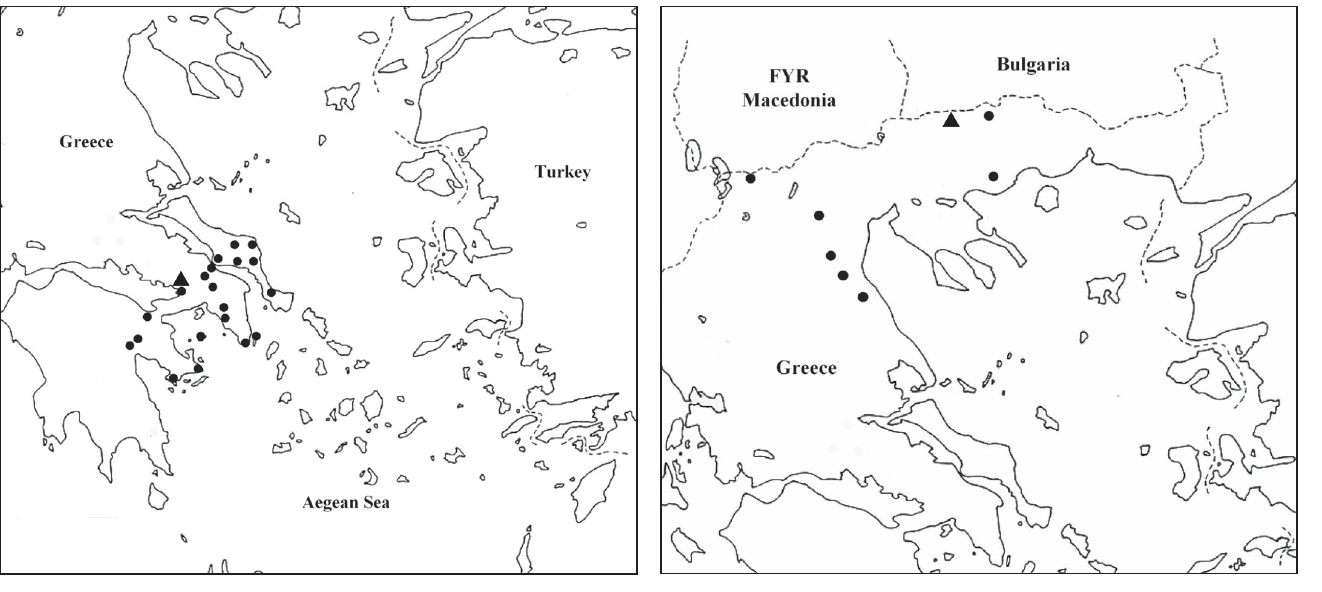
Figure 2. Total known distribution of Poecilimon propinquus (• lit- erature localities, ▲ new locality).